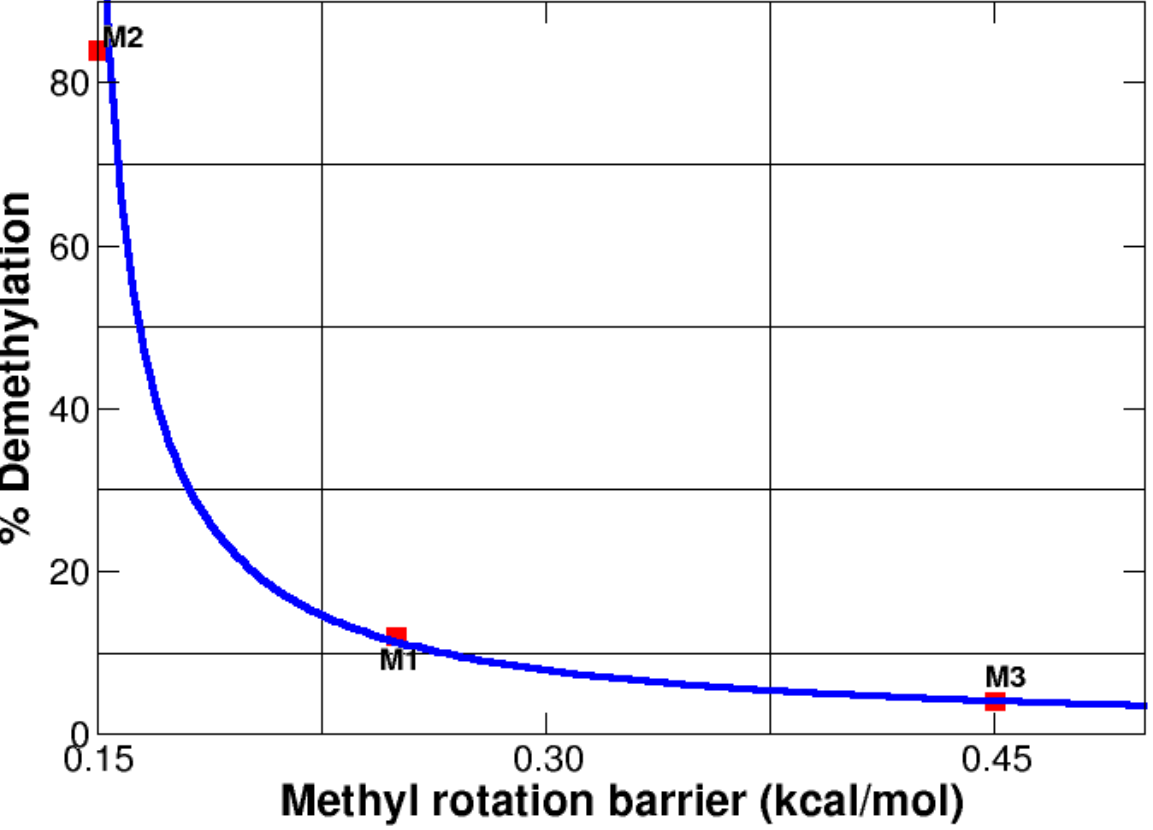
Figure 8. Ability to eliminate methyl groups in caffeine as a function of the rotational barrier. Experimental data (red squares) taken from Ref.